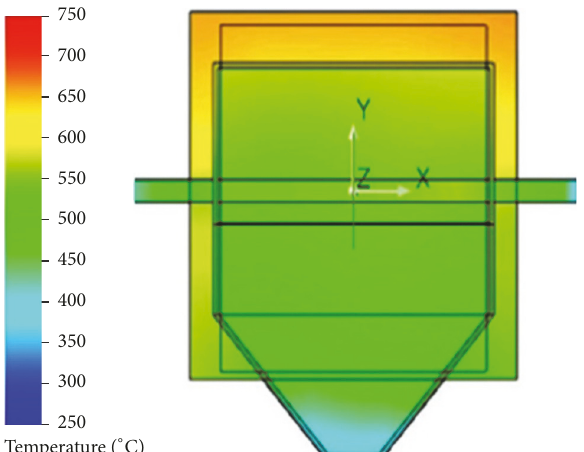
Figure 5: Model used to analyze the temperature variation in the reactor with change in the gap between the heater and the reactor.